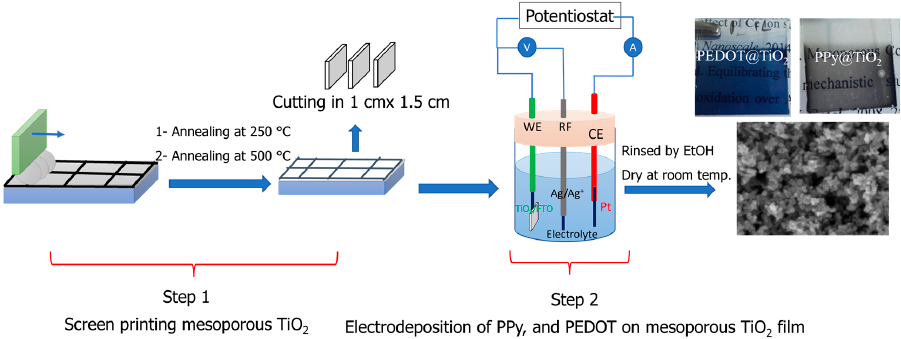
Figure 7. The Schematic representation for the preparation of PPy and PEDOT via electrodeposition process. tion